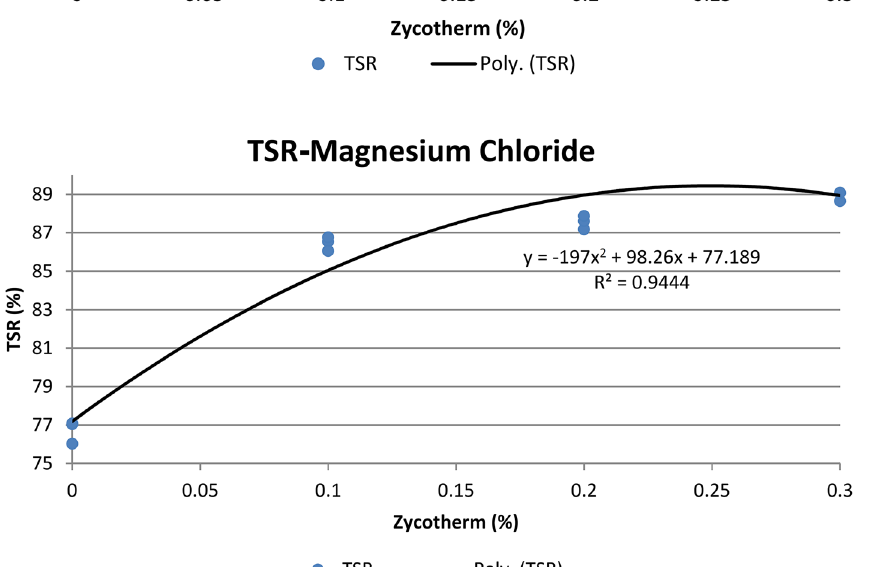
Fig. 12 Regression model of TSR for samples saturated with magnesium chloride